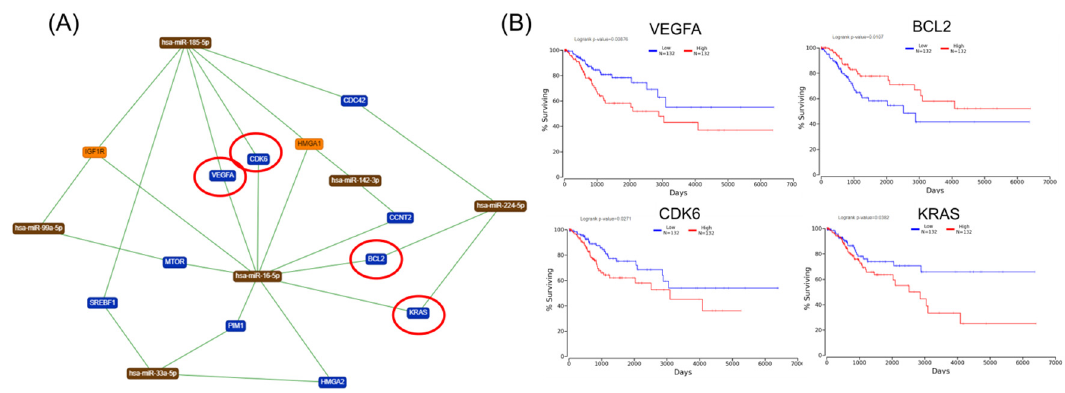
Figure 10. mRNA-mRNA network interaction in CC. (A) An mRNA–miRNA interaction map based on miRNAs predicting overall survival in CC, generated using miRtargelink (Available online: https://ccb-web.cs.uni-saarland.de/mirtargetlink/). Only those strong interactions are herein presented; (B) network genes predicting overall survival rate in CC; red circles are for genes predicting overall survial rate in CC.